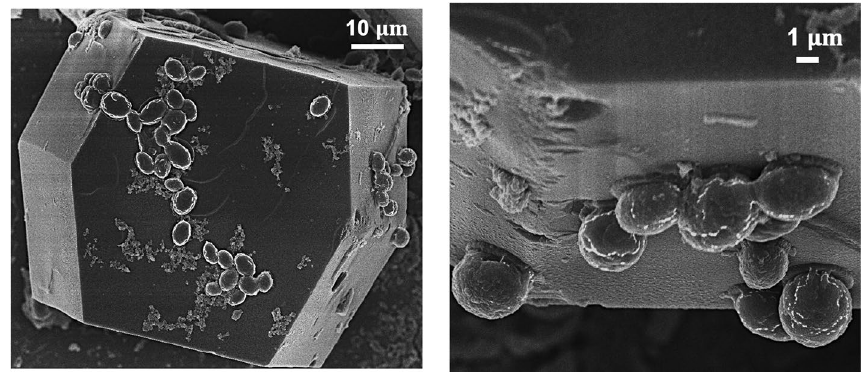
Figure 8. SEM images of S. cerevisiae and lysozyme crystal from hanging-drop experiments with C SC [Low] biotemplates and 20 mg/mL lysozyme.